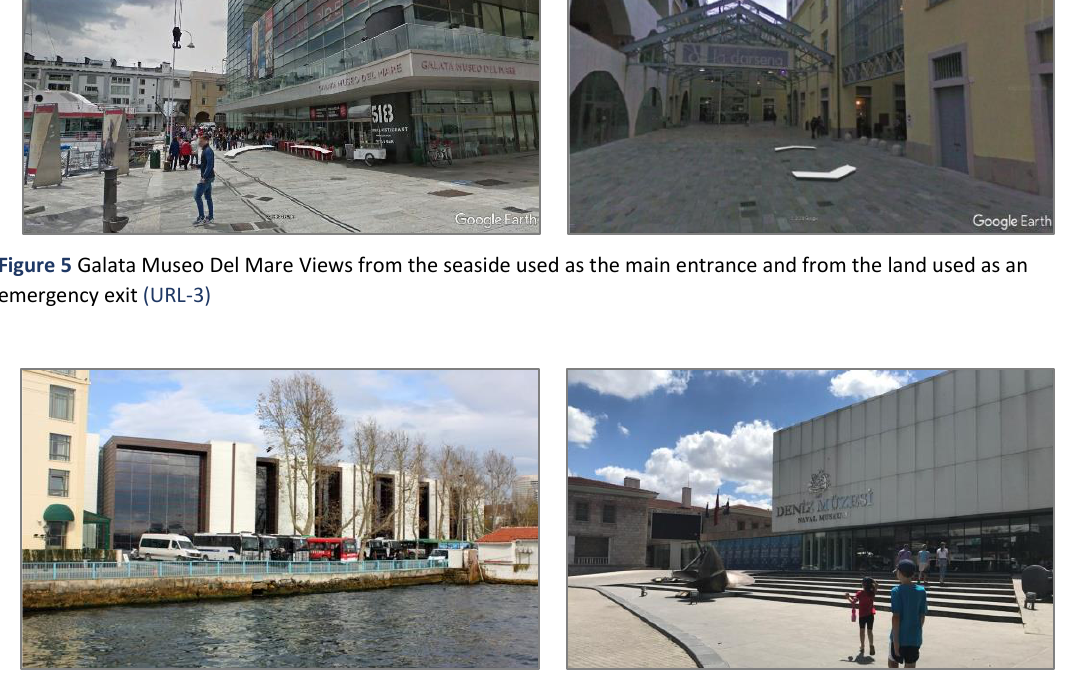
Figure 6 İstanbul Deniz Müzesi Views from the seaside used as an emergency exit and from the land used as the main entrance